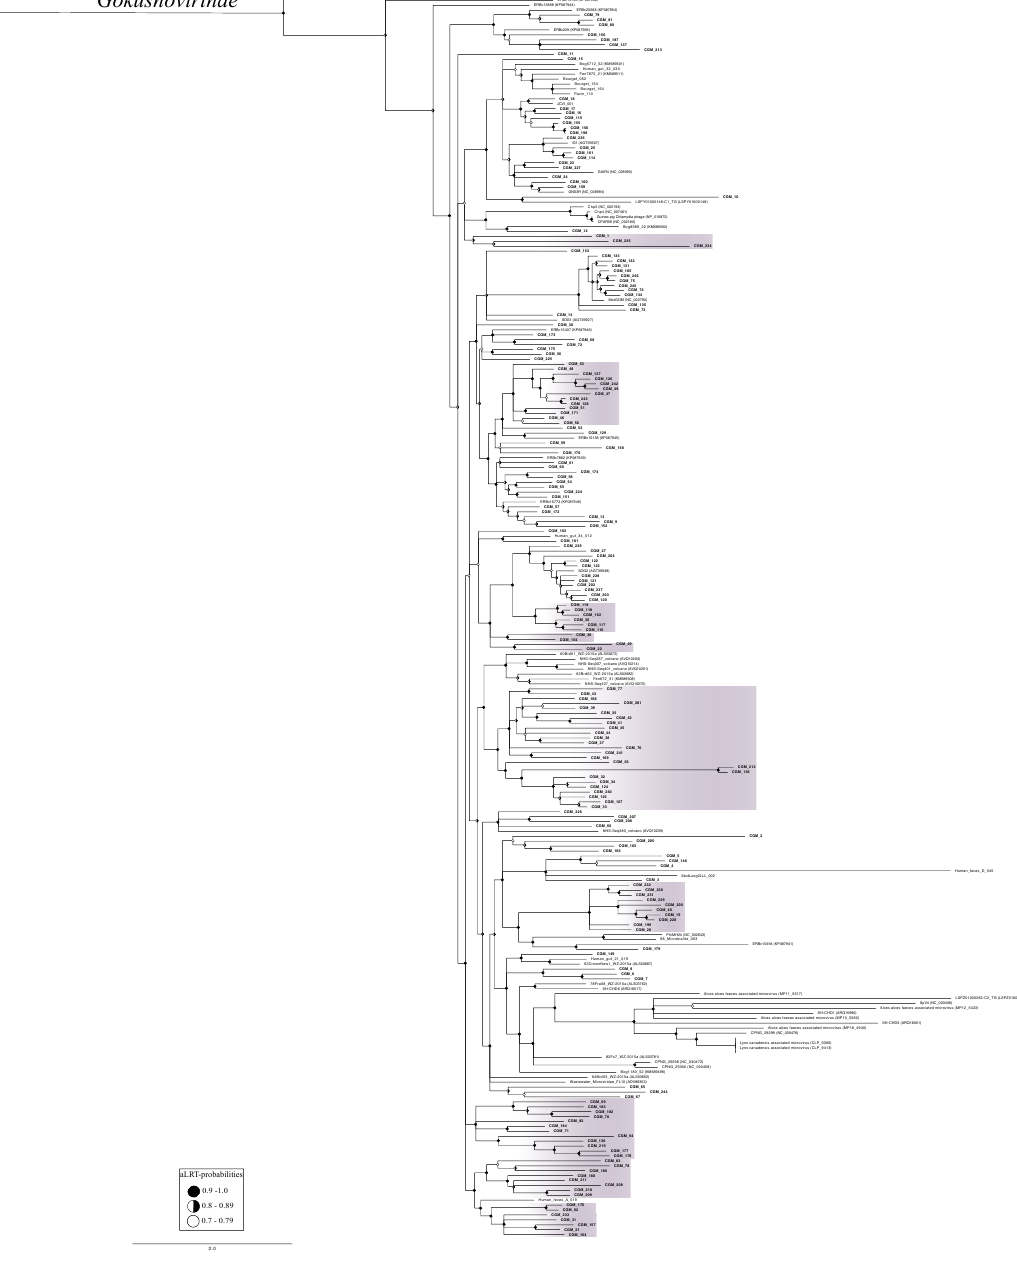
Figure 2. Maximum likelihood phylogenetic tree of predicted major capsid protein (MCP) sequences from the Ciona gut Microviridae (CGM, n = 188) that clustered within the established Gokushovirinae subfamily. MCP sequences representing Alpavirinae were used as an outgroup. The tree was created via PhyML with aLRT-probabilities; the scale bar represents the number of amino acid substitutions per site. Branches with probability values less than 0.7 were collapsed. Values greater than 0.7 are indicated at nodes. Clades highlighted in purple represent those where CGM sequences do not group with any previously described MCP sequences. Note: Accession numbers for sequences used in this analysis are listed in Supplementary Tables S1 and